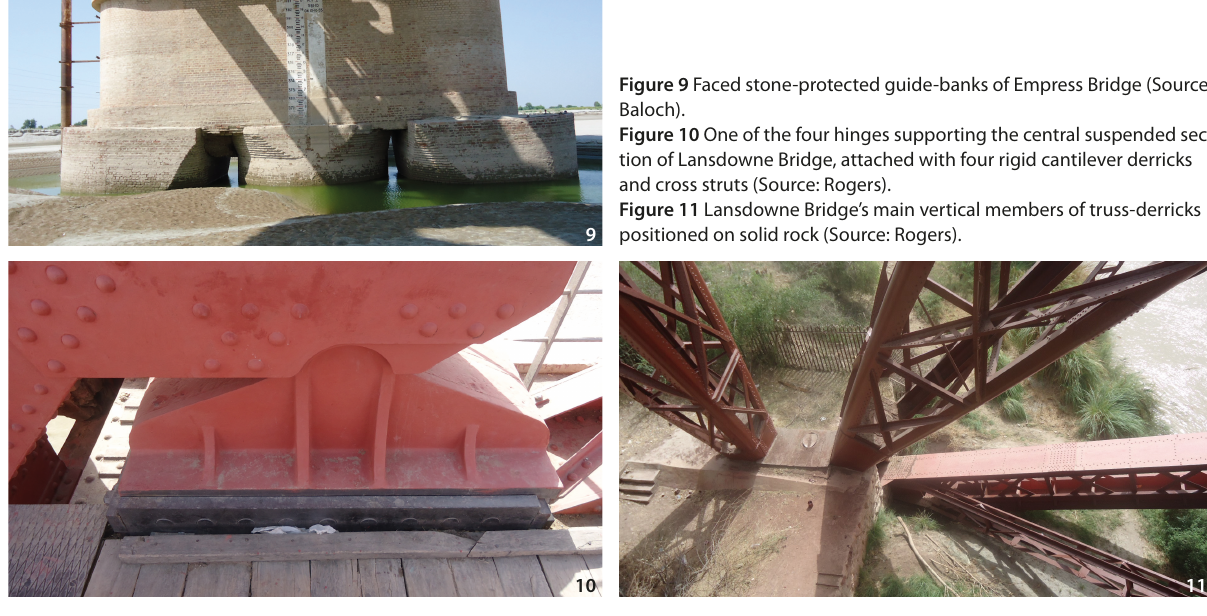
Figure 9 Faced stone-protected guide-banks of Empress Bridge (Source: Baloch). Figure 10 One of the four hinges supporting the central suspended sec- tion of Lansdowne Bridge, attached with four rigid cantilever derricks and cross struts (Source: Rogers). Figure 11 Lansdowne Bridge’s main vertical members of truss-derricks positioned on solid rock (Source: Rogers).